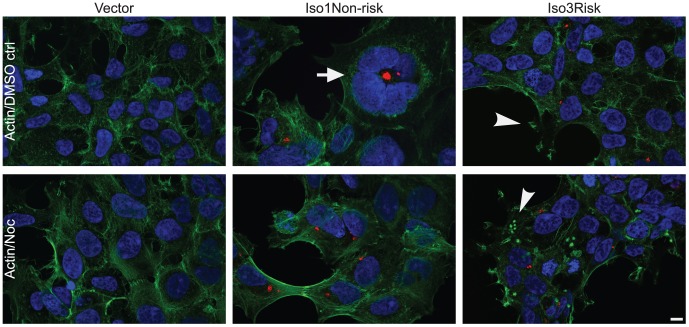
Morphological and cytoskeletal alterations in CCHCR1-overexpressing stable cell lines. Actin staining (green) shows differences in the cell morphology and cytoskeleton between cells expressing different CCHCR1 isoforms (red), here presented vector control, Iso1Non-risk, and Iso3Risk cells. Isoform 1 and 3-expressing cells differ in cell size and shape; Iso1Non-risk cells are larger and rounder than Iso3Risk and their cell nuclei are larger. Furthermore, of the CCHCR1 cell lines especially Iso1Non-risk cells show multilobulated cell nuclei (arrow). The isoform 3-expressing cells also exhibit more pseudopodia with actin rich tips, indicated by an arrowhead (upper panel). The most obvious change in actin organization is observed in the Iso3Risk cells, after treatment with nocodazole (Noc); actin forms punctate staining resembling podosome-like structures, indicated by an arrowhead (lower panel). DAPI stained nuclei are shown in blue. Scale bar 10 µm.